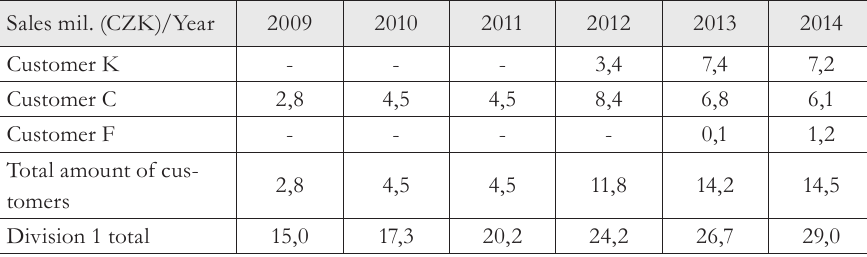
Tab. 1. – Sales of strategic customers for Division 1. Source: Authors. Sales mil. (CZK)/Year